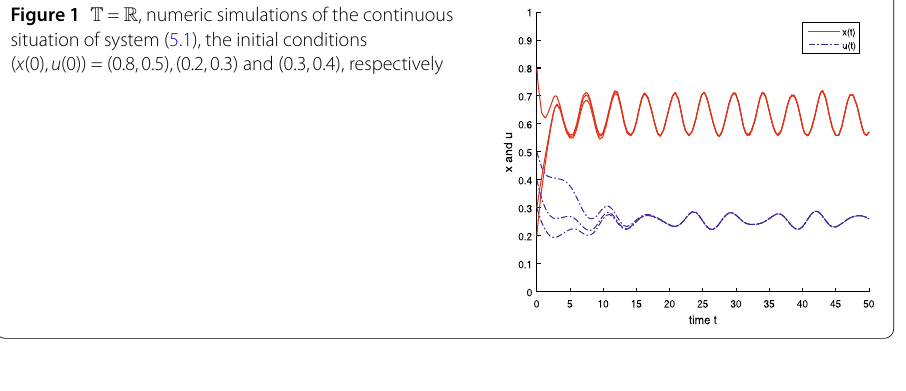
Figure 2 T = Z , numeric simulations of discrete situation of system (5.1), the initial conditions ( x (0), u (0)) = (0.2,0.3), (1,0.5) and (0.8,0.6),